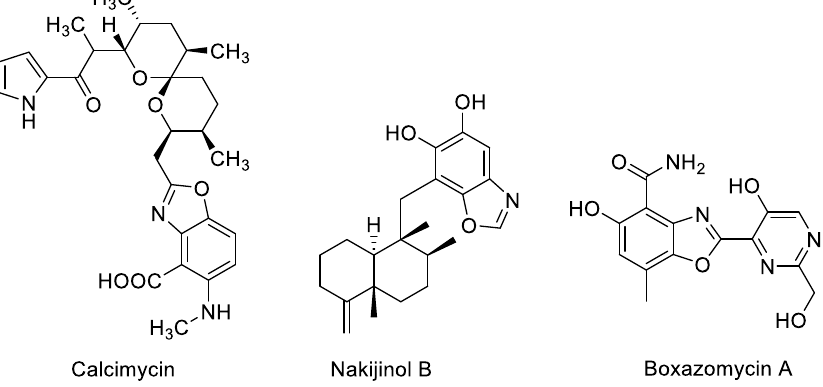
Figure 1. Structures of some biological active benzoxazole derivatives.